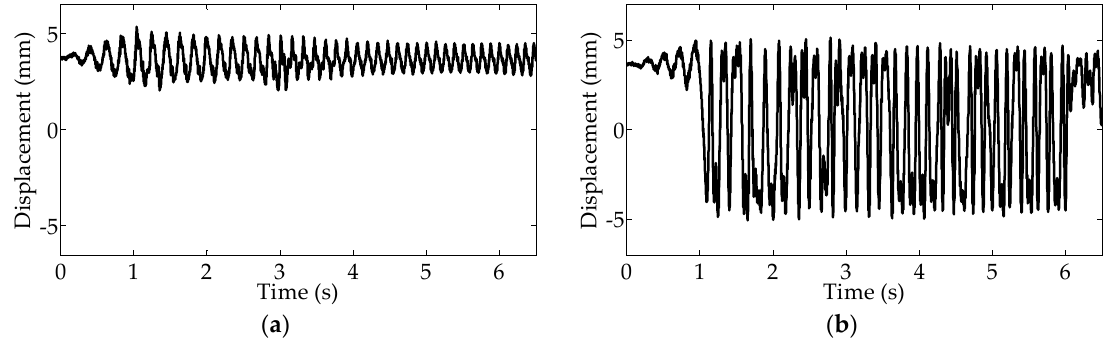
Figure 14. Experimental displacements: ( a ) under the up-sweep excitation; ( b ) under the combination of the up-sweep excitation and on-road noise excitation.